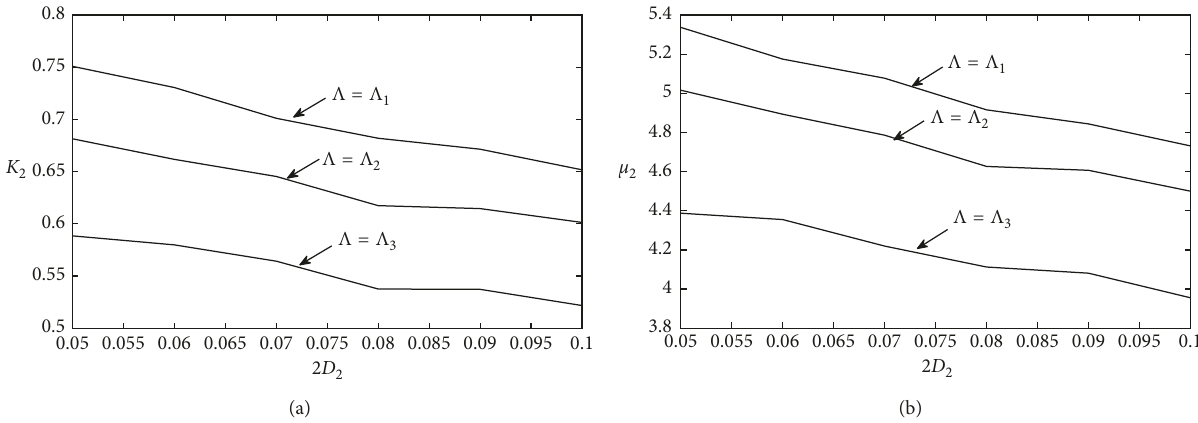
Figure 5: The control effectiveness K